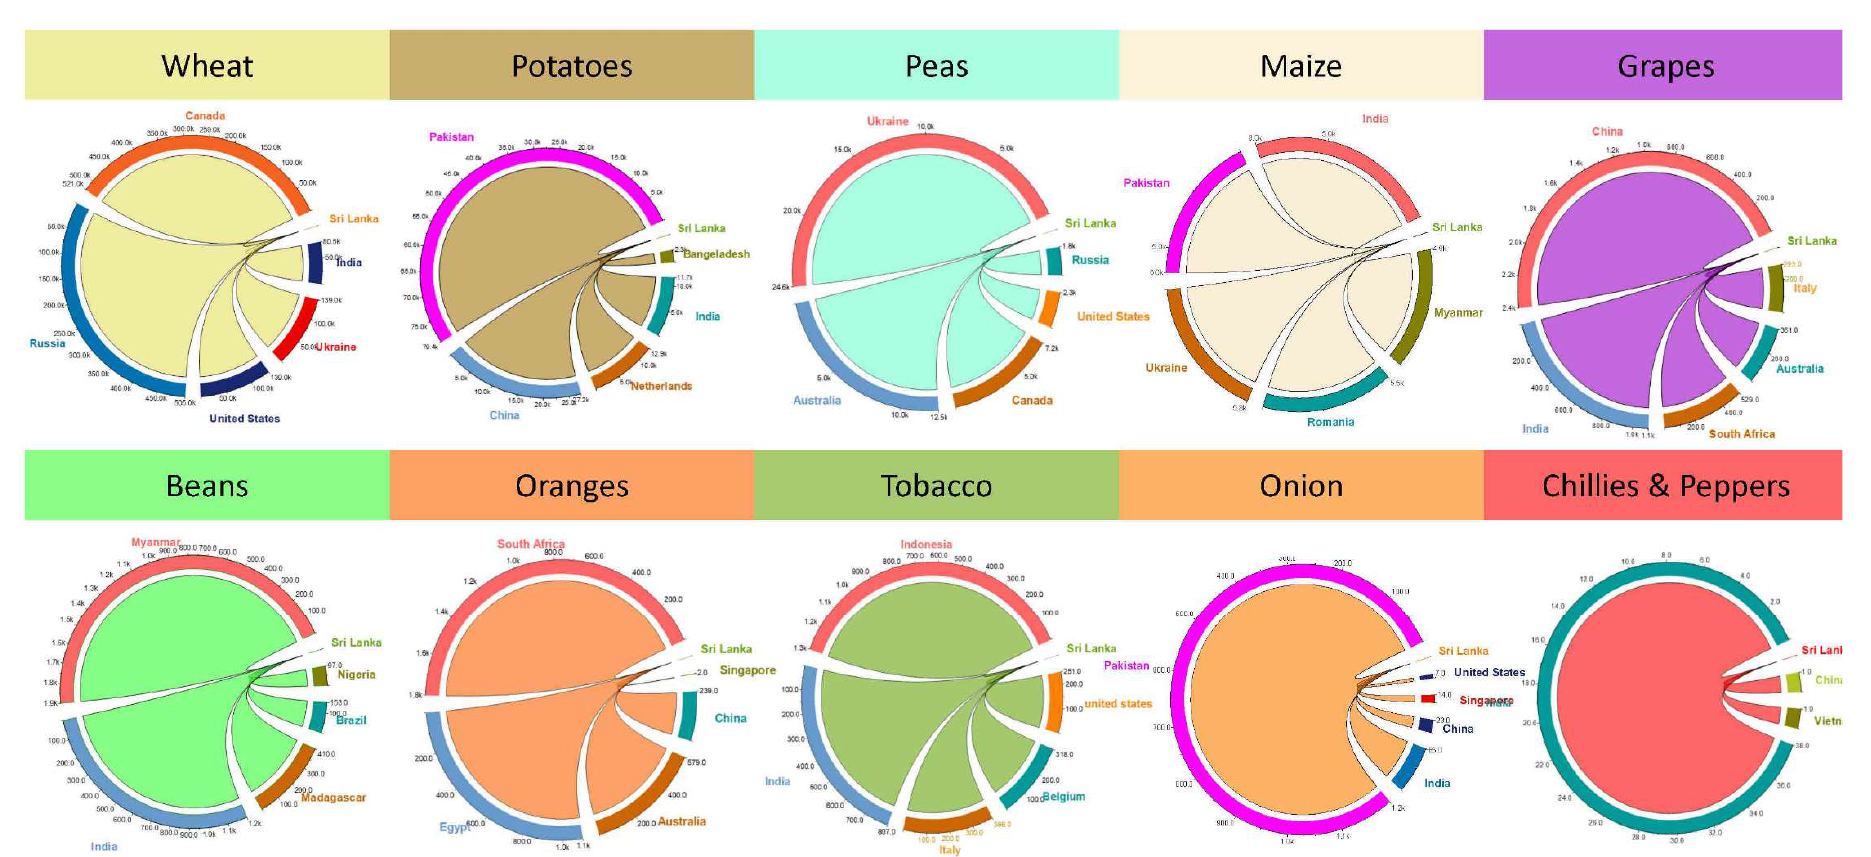
Figure 8. Imports in 2020 with details of countries for each top import crop.